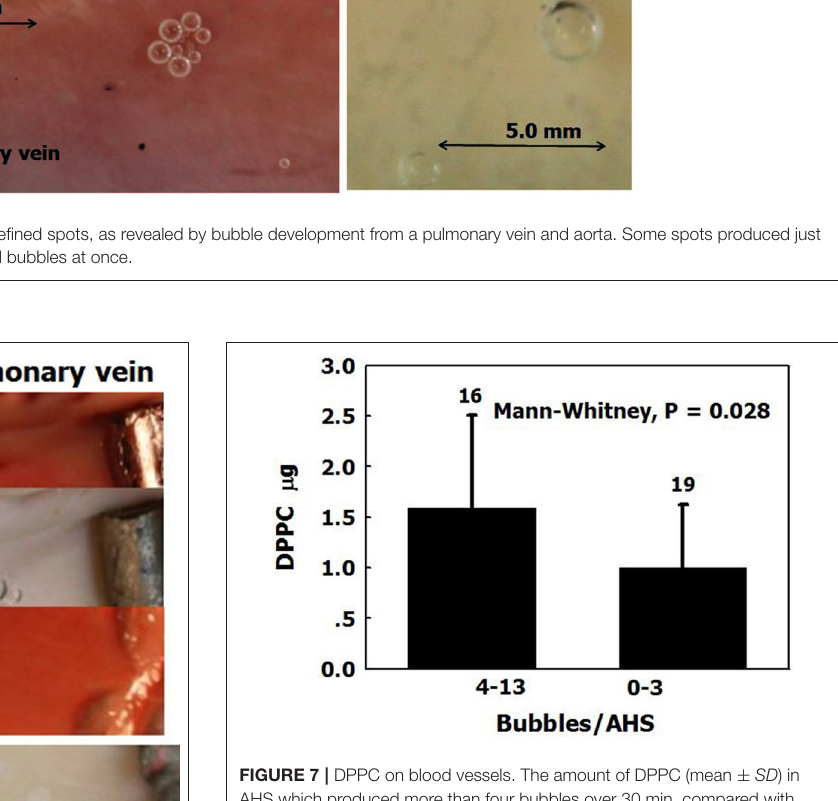
Dipalmitoylphosphatidylcholine (DPPC) is the